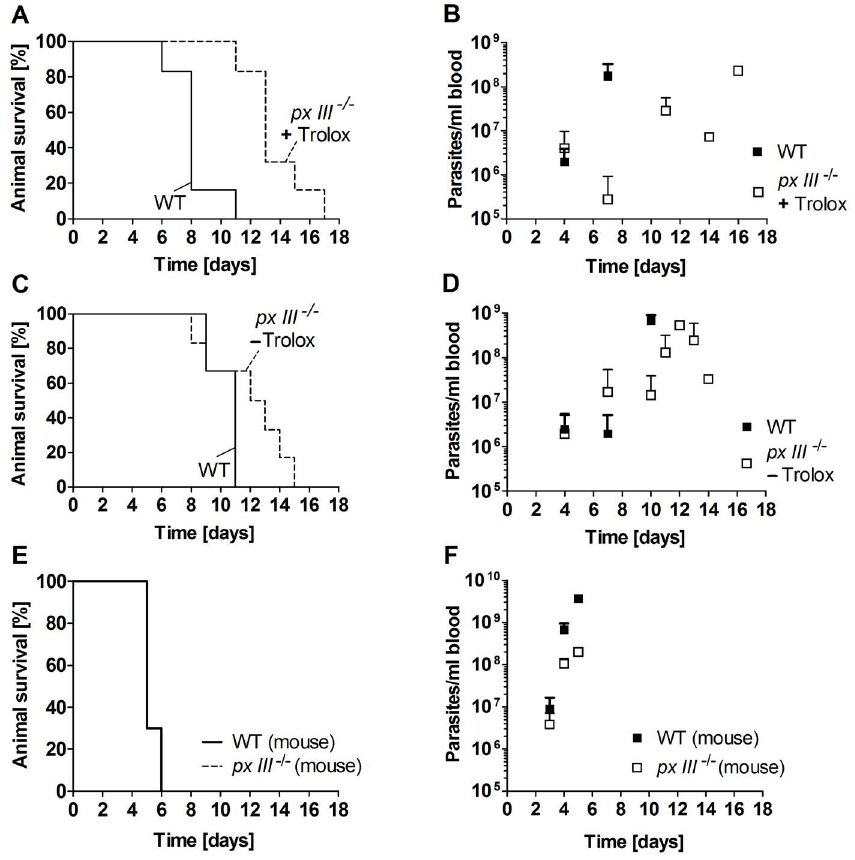
Figure 6. Infectivity of pxIII 2 / 2 and WT T.brucei . A. and B. Female BALB/cJ mice (n=6/group) were infected intraperitoneally with 10 4 WT parasites or px III 2 / 2 cells that, prior to infection, had been cultivated in medium supplemented with 100 m M Trolox, and C. and D. in medium without Trolox. E. and F. Mice (n=3/group) were inoculated with px III 2 / 2 and WT parasites isolated from infected animals (for details see Materials and Methods). A. , C. , and E. Kaplan-Meyer plots for animal survival, B. , D. , and F. Average parasite load in blood samples taken from the animals at the indicated times. All data are the mean value 6 SD.